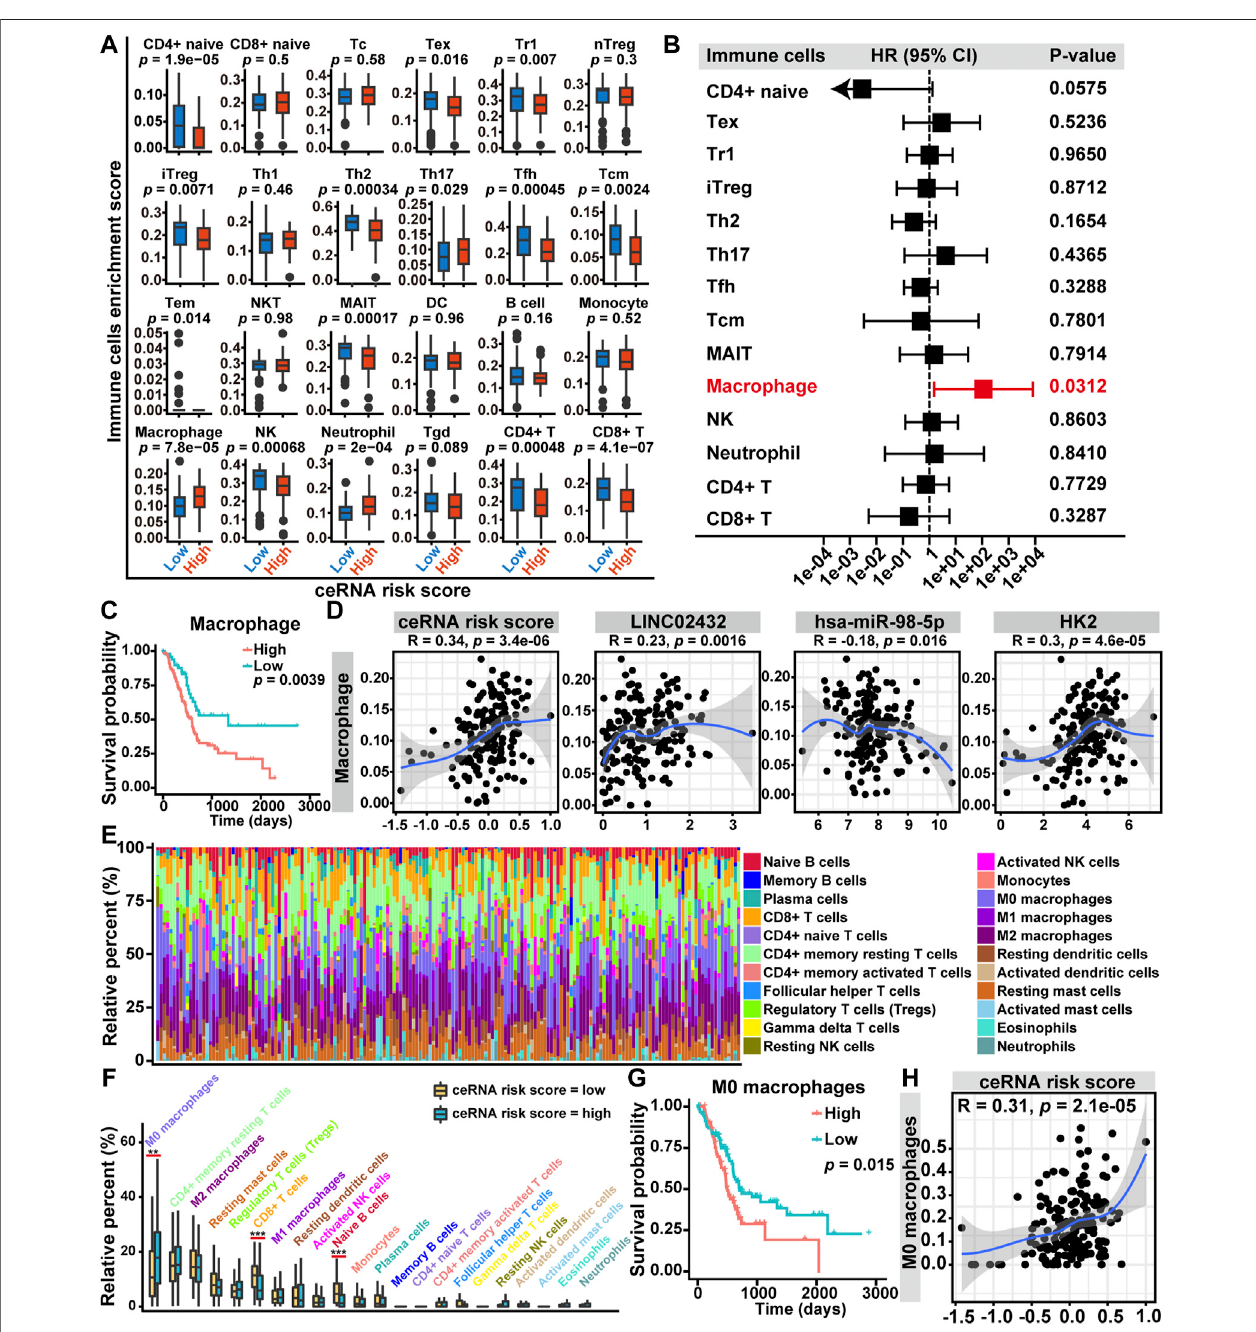
FIGURE 5 | Relationship between LINC02432/hsa-miR-98 – 5p/HK2 ceRNA network and tumor-in fi ltrating immune cells in the TME of PAAD. (A) The box plots showed the differences in the proportions of 24 tumor-in fi ltrating immune cells among the high ceRNA risk score and low ceRNA risk score groups. (B) Univariate Cox regression analysis of14 differentially expressed tumor-in fi ltrating immunecells. (C) Kaplan-Meier curve analysisof overallsurvivalin high macrophages fraction and low macrophages fraction groups. (D) The Pearson correlation among the fraction of macrophages and the LINC02432/hsa-miR-98 – 5p/HK2 ceRNA network. (E) Based on the CIBERSORT algorithm, histograms showed the in fi ltration of 22 immune cells in each sample. (F) The box plots showed the difference ofthe 22 in fi ltrating immune cells between groups with different ceRNA risk scores. (G) Kaplan-Meier curves of M0 macrophages for overall survival in PAAD patients. (H) The Pearson correlation between the fraction of M0 macrophages and the ceRNA risk